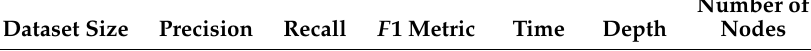
Table 1. Decision